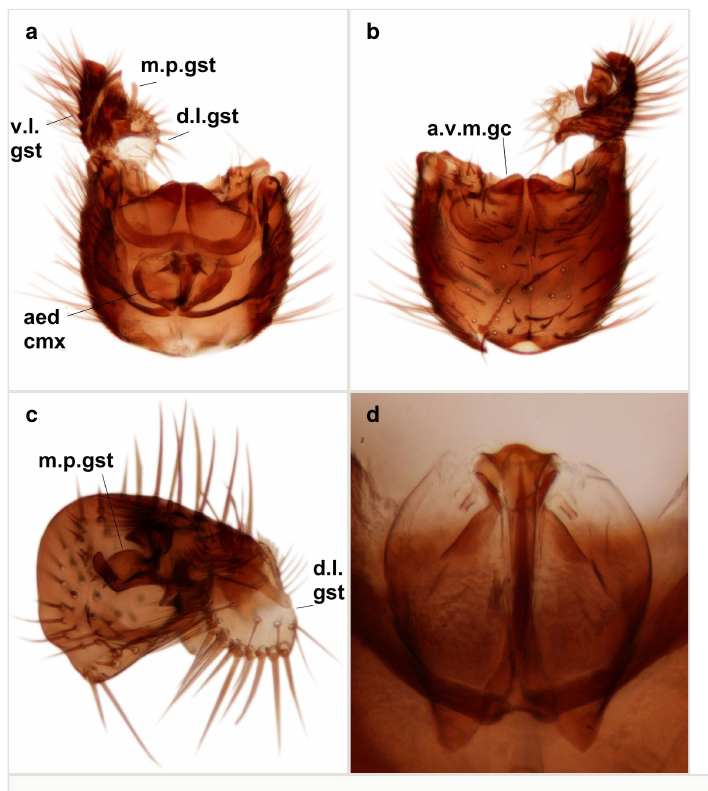
Phronia elegantula Hackman, male hypopygium, DIPT-JS-2016-0166. a : Hypopygium, dorsal view. d.l.gst=dorsal lobe of gonostylus, v.l.gst=ventral lobe